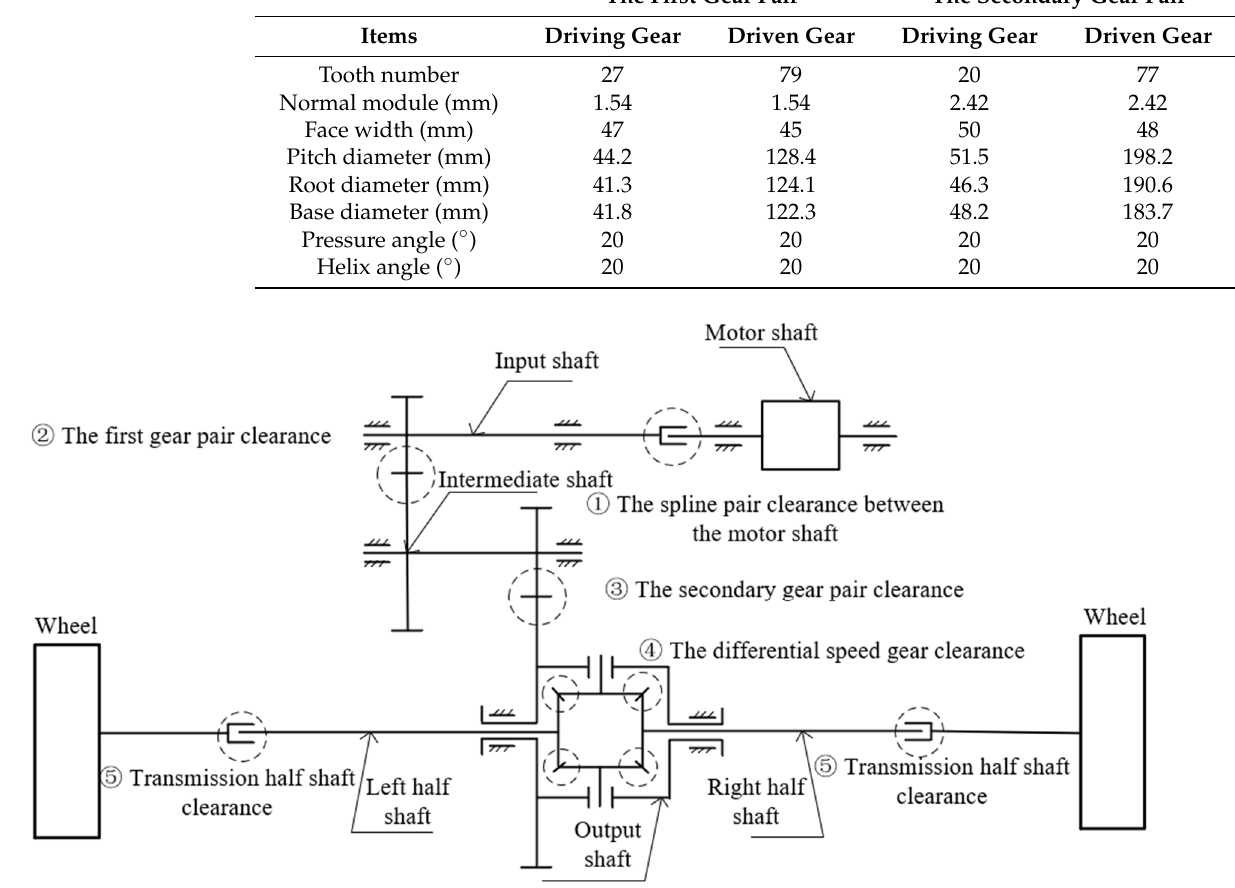
Figure 3. Schematic diagram of the backlashes in the powertrain system.